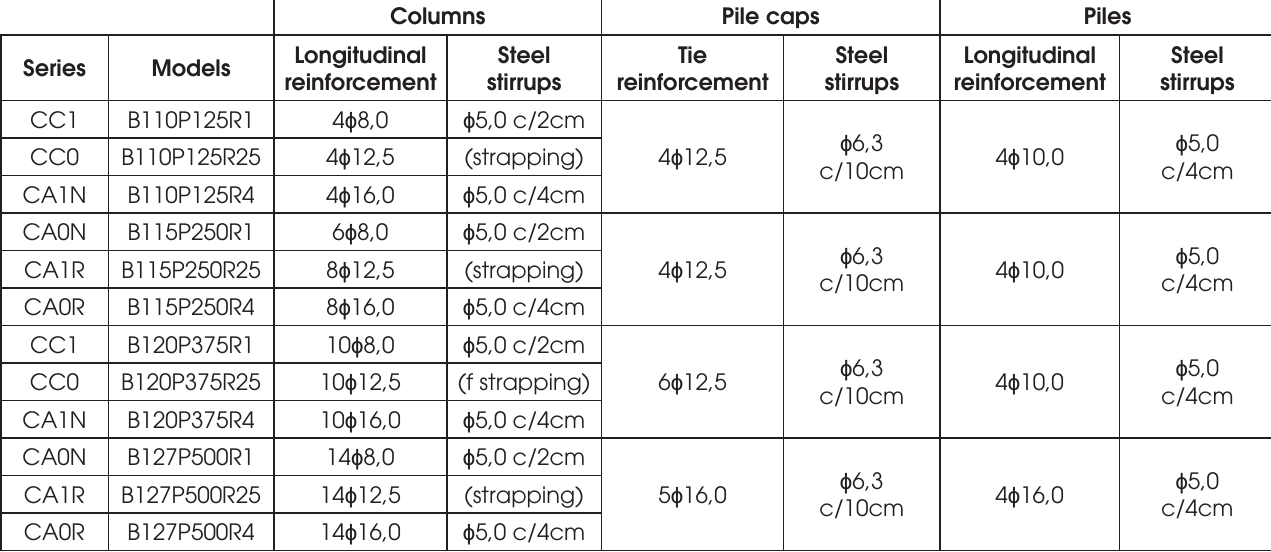
Summary of reinforcement of experimental models